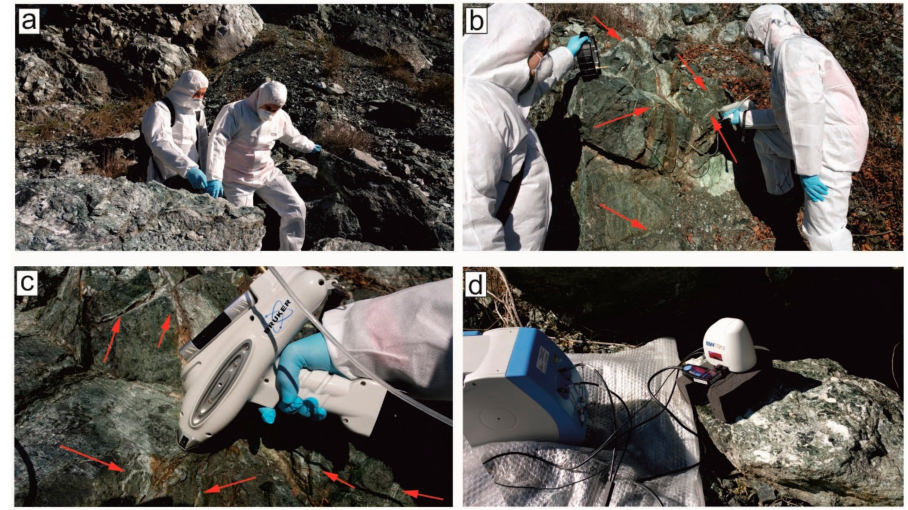
Figure 2. ( a ) Preliminary site survey, ( b ) p-XRF data collection, ( c ) closely view data collection by p-XRF, ( d ) p- µ R data collection. Veins indicated by red arrow.